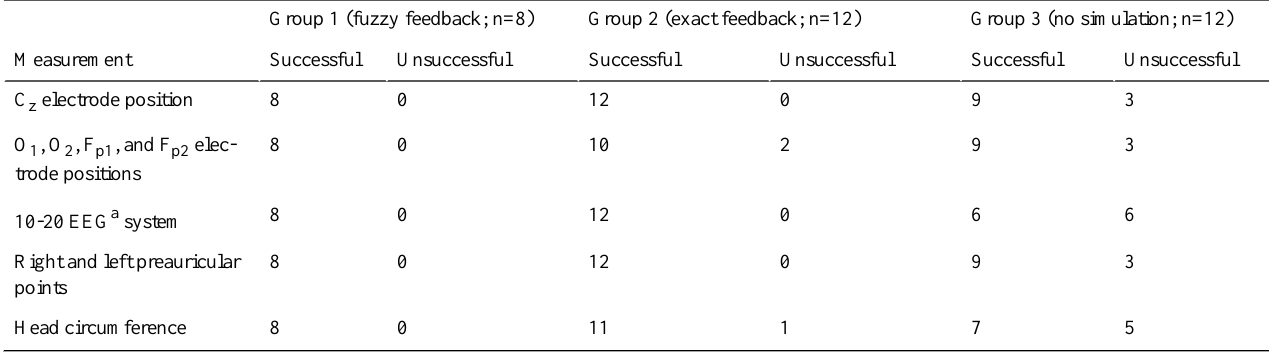
Table 2. Results from practical evaluations of electrode